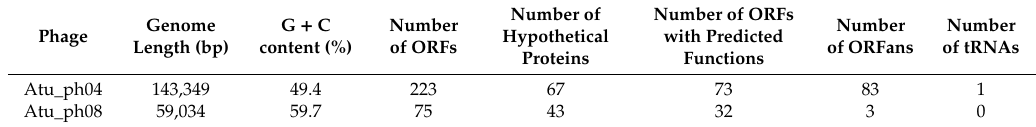
Table 3. Summary of key genomic features of Atu_ph04 and Atu_ph08.